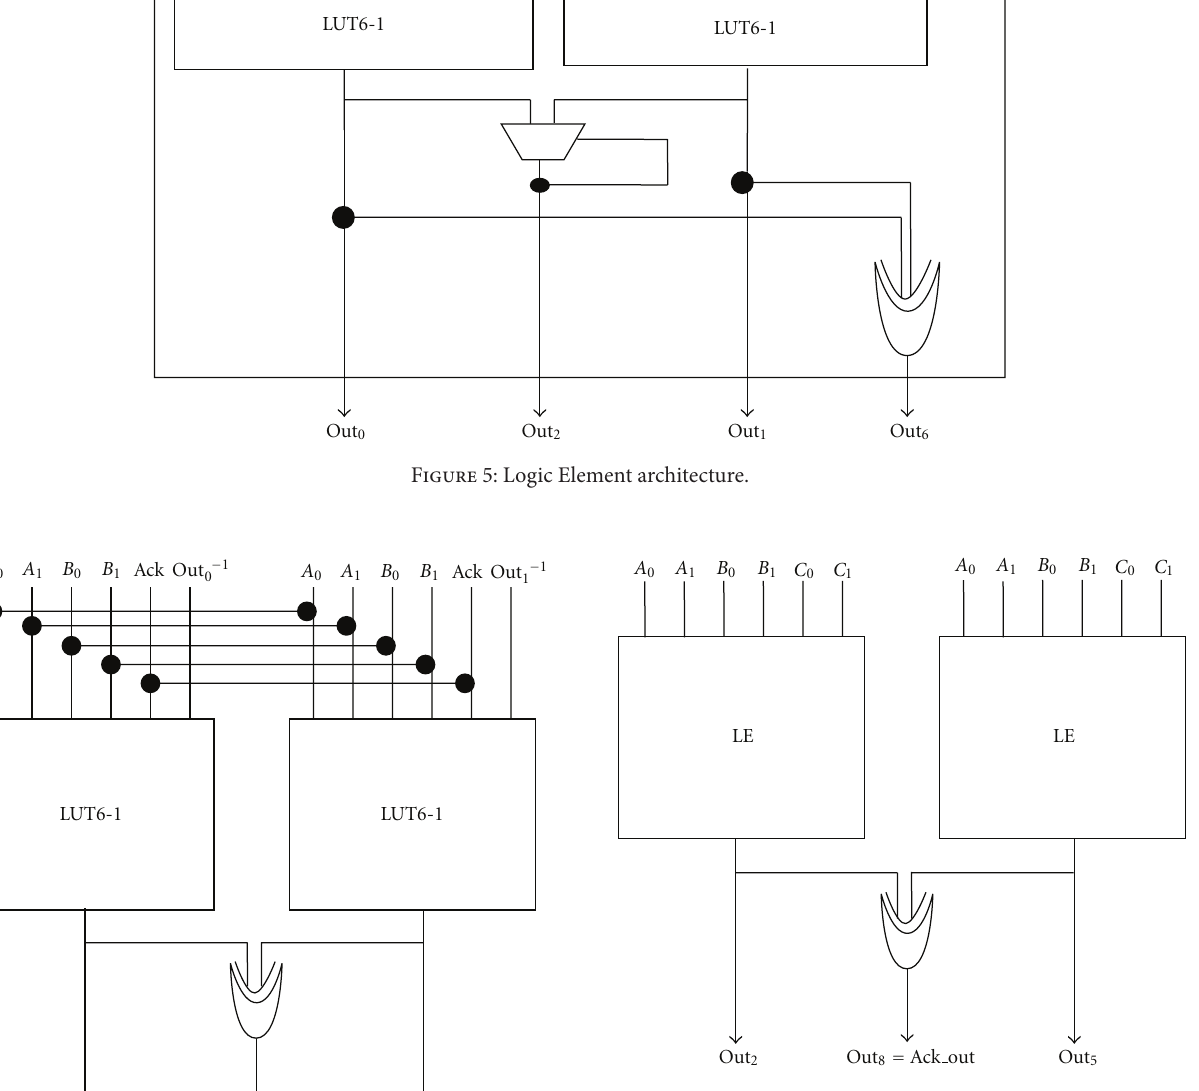
Figure 7: 3-input dual-rail gate